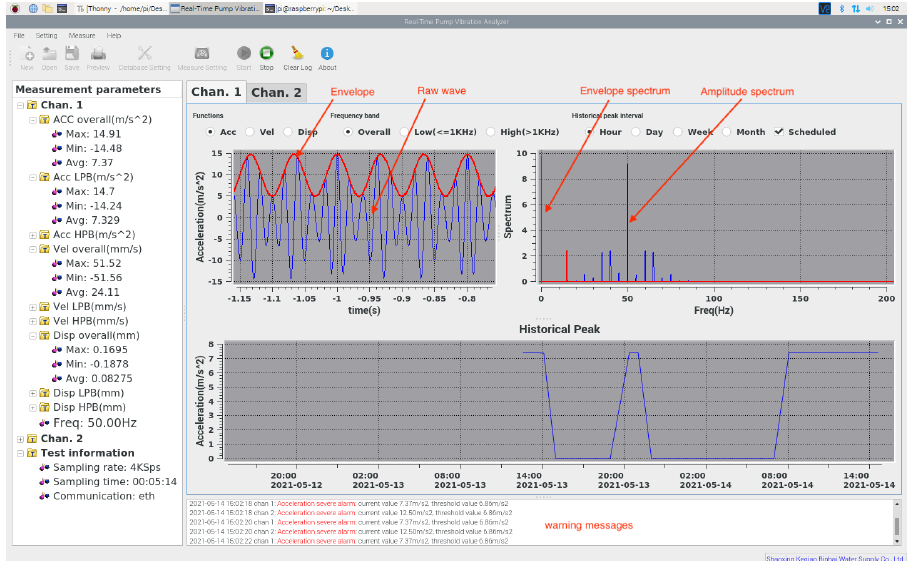
Figure 3. Real-time monitoring GUI for Raspberry Pi-based vibration test